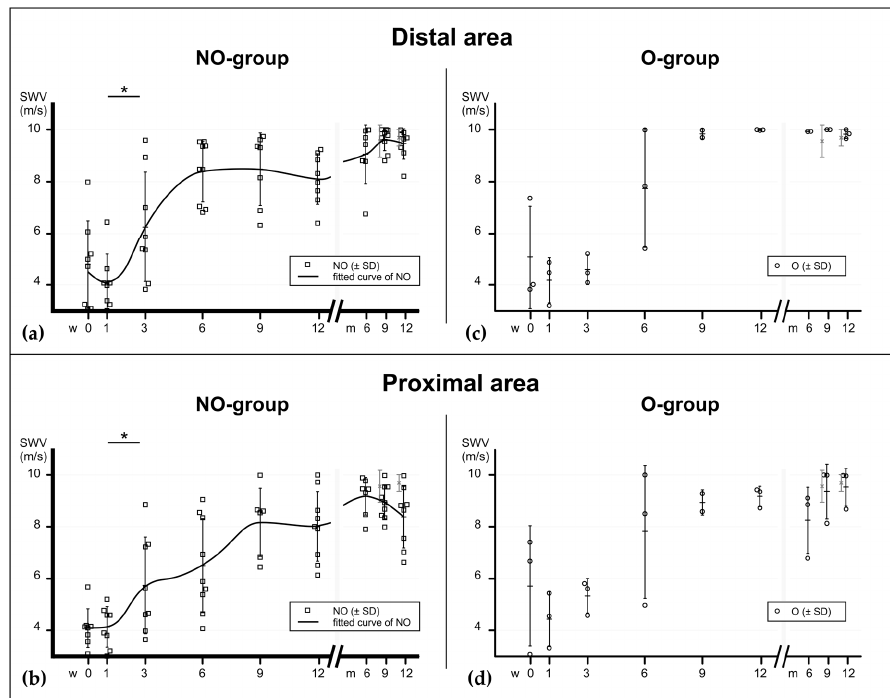
Figure 3. Material elastic properties during tendon healing at the area very distal and very proximal to the rupture, assessed with SWE, expressed in m/s. ( a ) In the mainly invested group—the non- operatively treated patients—the elastographical pattern at the distal area also shows a bi-sigmoidal increase (fitted curve), similarly to the rupture site. ( b ) In the proximal area the increase appears to occur more delayed. Significant differences between the consecutive time points of the NO-group are noted with asterisks (*). p values: * ≤ 0.05. ( c , d ) Elastographic values of operatively treated patients. NO = non-operatively treated patients, O = operatively treated patients, CL = contralateral tendons